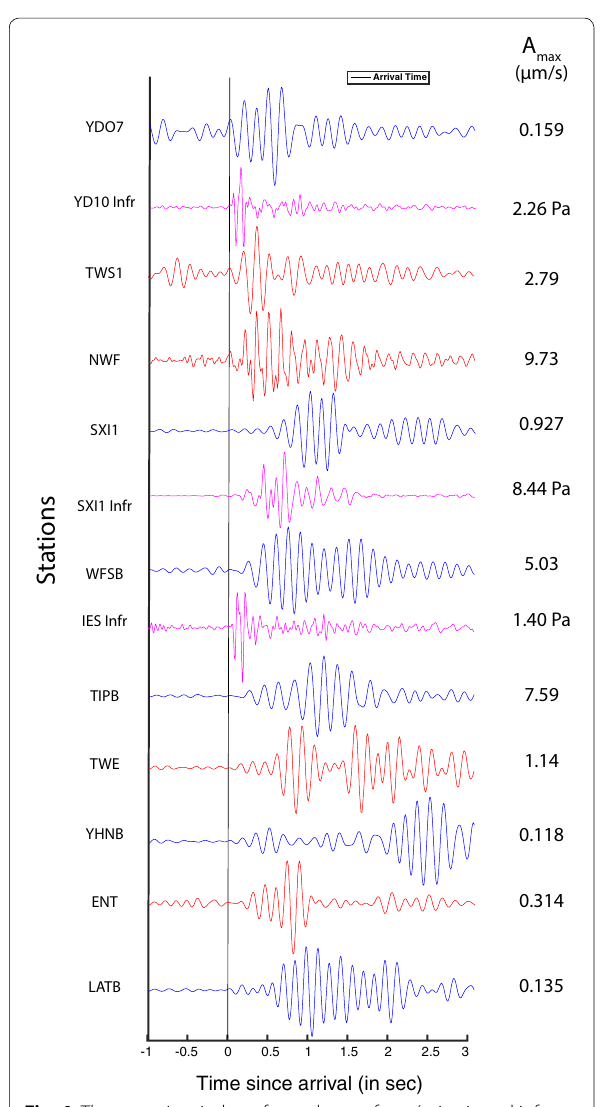
Fig. 4 The zoom-in windows for each waveform (seismic and infra- sound); the characteristic first motions are manifested. The vertical , thin black line marks the arrivals of the shockwaves at the stations. The maximum amplitude for waveform at each station is labeled on the right for reference